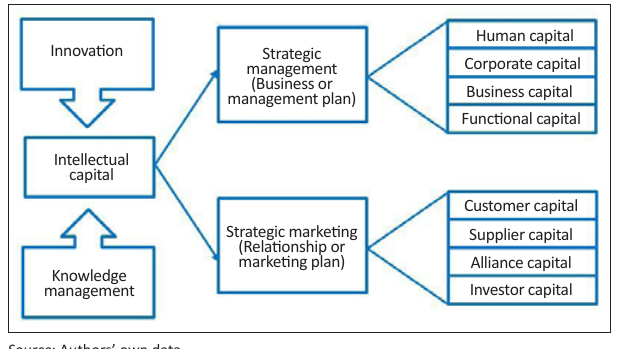
FIGURE 2: MultiChoice’s Intellectual Capital